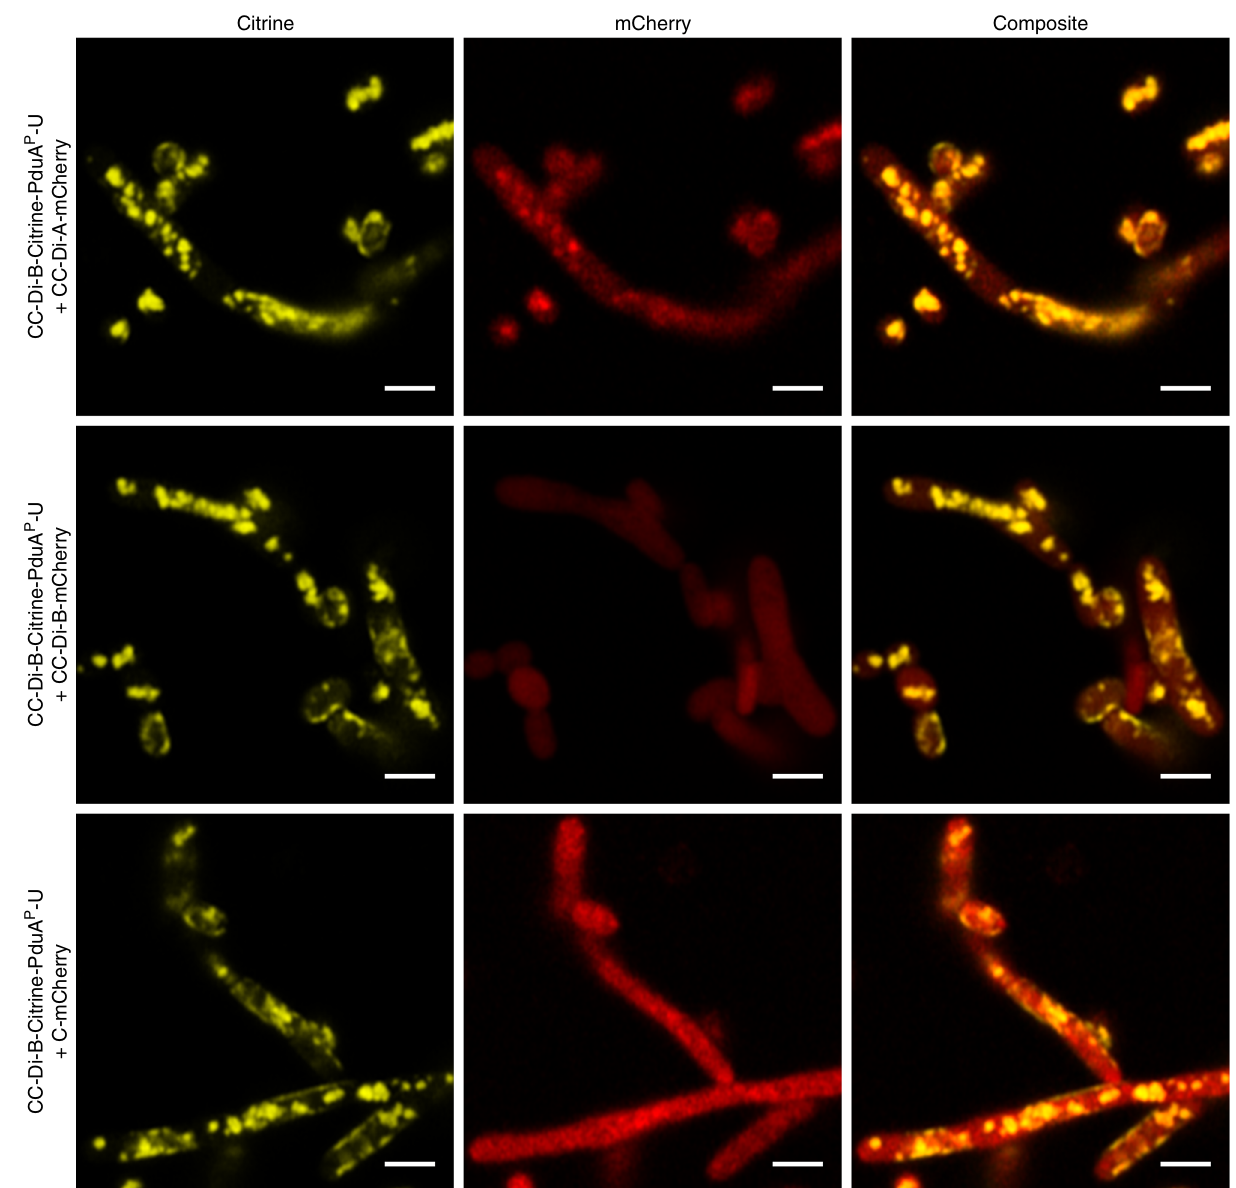
Fig. 7 Localization of fl uorescent proteins to circularly permuted coiled-coil labeled BMCs. Confocal analysis of E. coli BL21 * (DE3) cells showing Citrine, mCherry and composite fl uorescence signals for cells expressing CC-Di-B-Citrine-PduA P -U in conjunction with CC-Di-A-mCherry, CC-Di-B-mCherry or C- mCherry. Scale bars show 2 µ